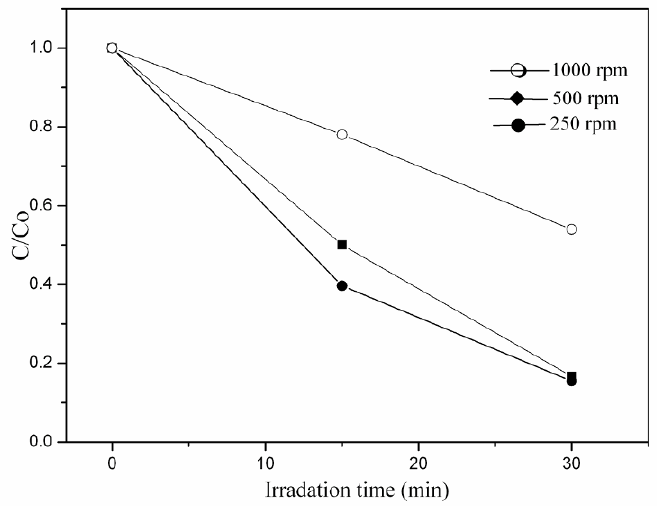
Figure 7. Photodegradation of Malachite Green (MG) on ZnO mechanically activated for 1 min at different milling speeds (250, 500 and 1000